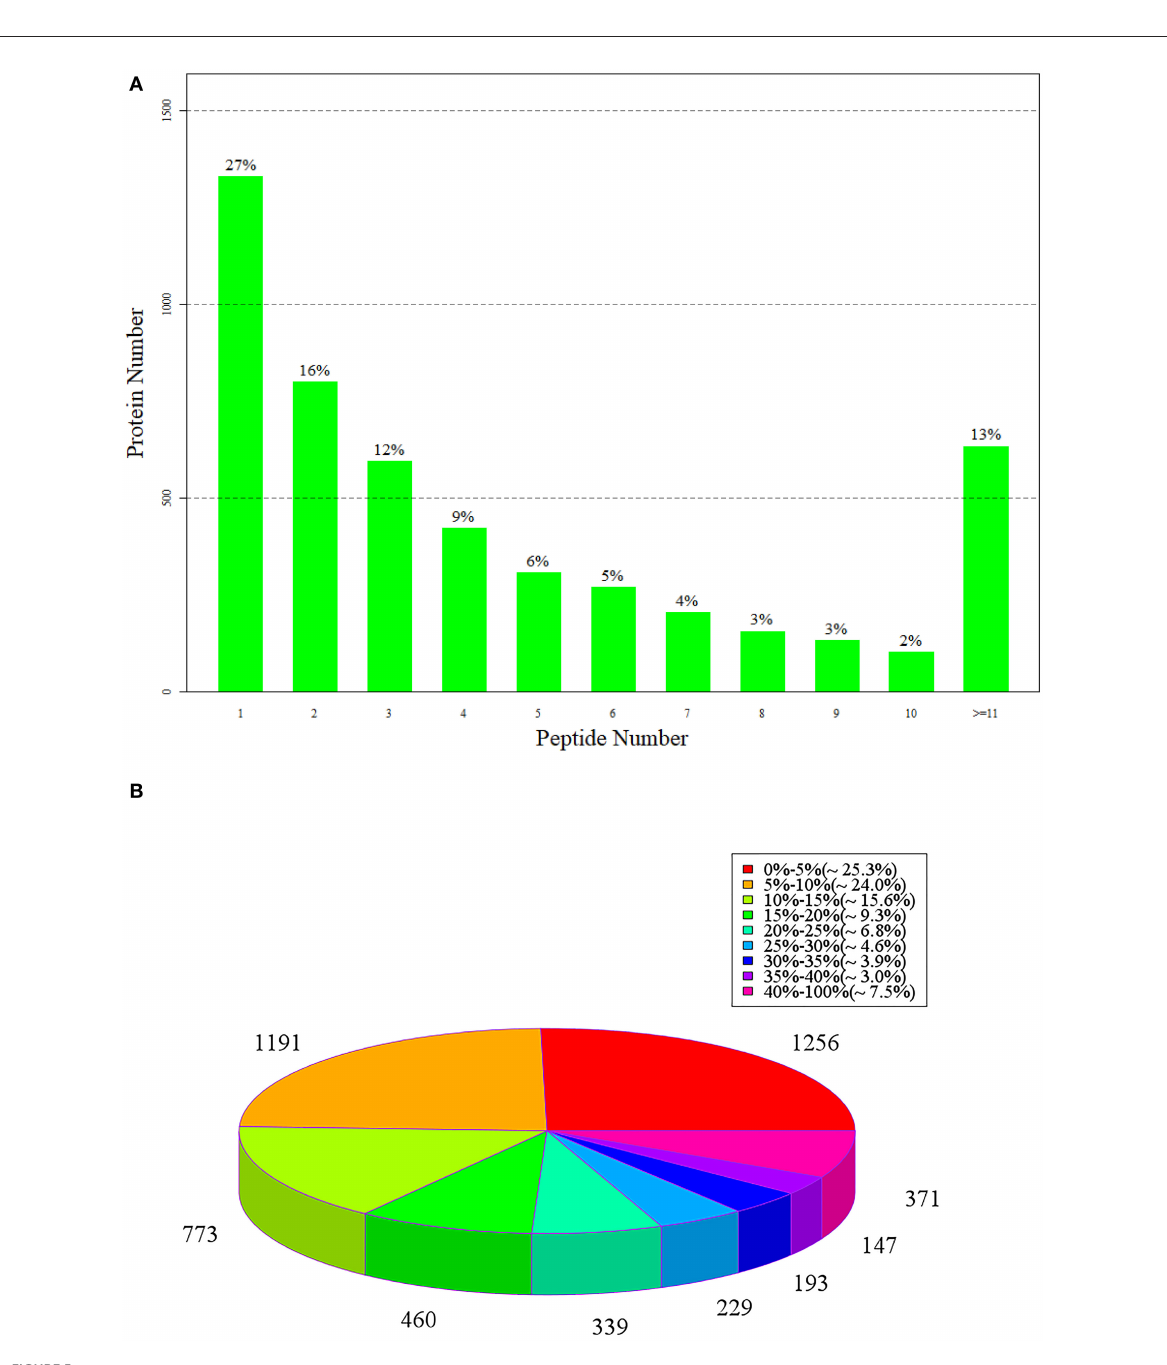
> 0, indicating that the overall expression of differential proteins was upregulated (Figures 8A,B). Thus, compound phosphate can promote this series of functions, these include: poly (A) RNA binding, cytosol, nucleosome, cytoplasm, histone H3–K27 trimethylation, nucleosome positioning, nucleosome assembly, histone H3–K4 trimethylation, protein binding,